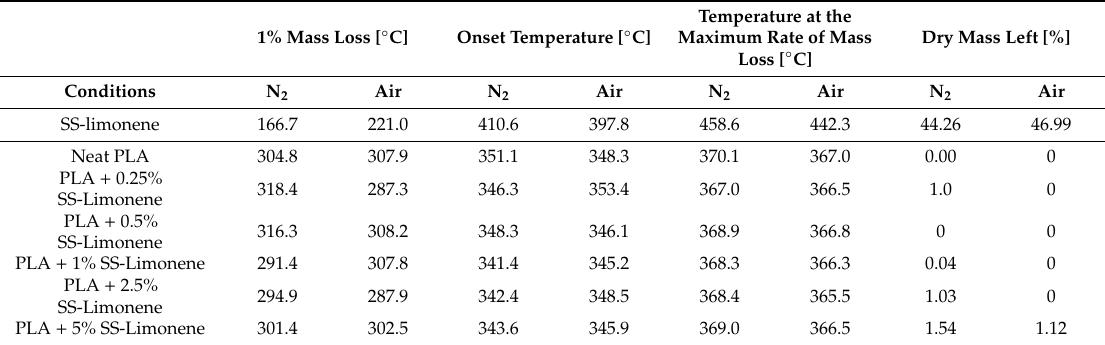
Table 2. Results of thermogravimetric analysis.